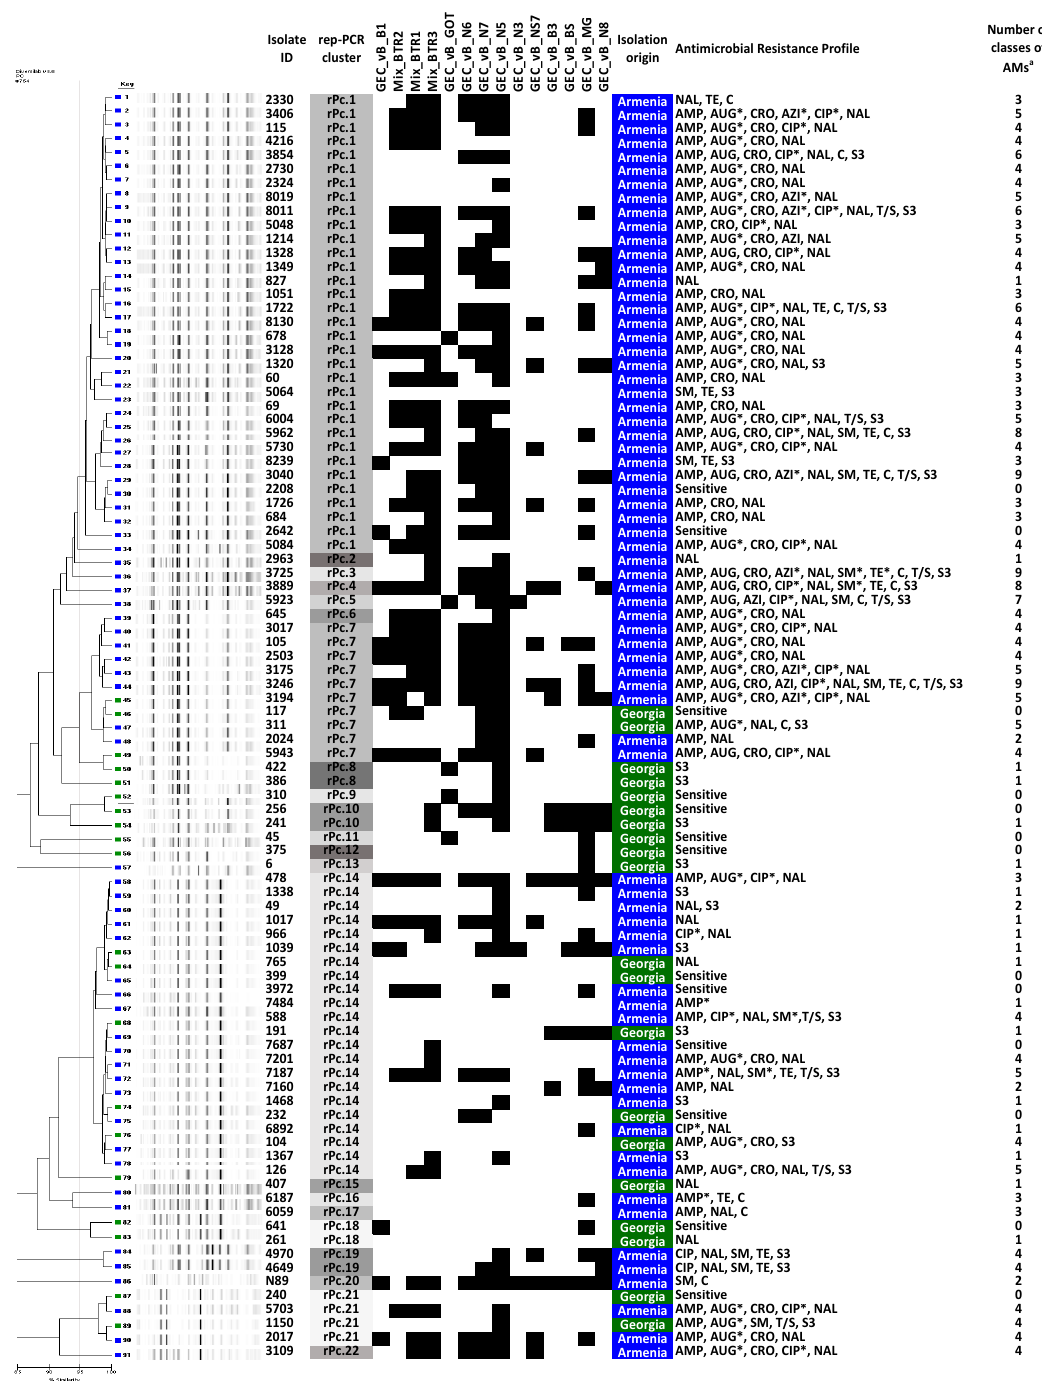
Figure 2. Unweighted pair group method with arithmetic mean (UPGMA) dendrogram of rep-PCR fingerprinting profiles, with corresponding phage typing and AM profiles. The report produced by the DiversiLab software truncated the dendrogram to only show relationships with similarities above 85%. a Number of classes of AMs to which the isolate showed resistant or intermediate phenotype; * Intermediate susceptibility to AMs. Black nods represent resistance to given phages. Rep PCR clusters are color coded for representation. AM, antimicrobial; AMP, ampicillin; AUG, amoxicillin + clavulanic acid; AZI, azithromycin; C, chloramphenicol; CIP, ciprofloxacin; CRO, ceftriaxone; NAL, nalidixic acid; SM, streptomycin; TE, tetracycline; T/S, trimethoprim-sulfamethoxazole; S3, sulfonamides.